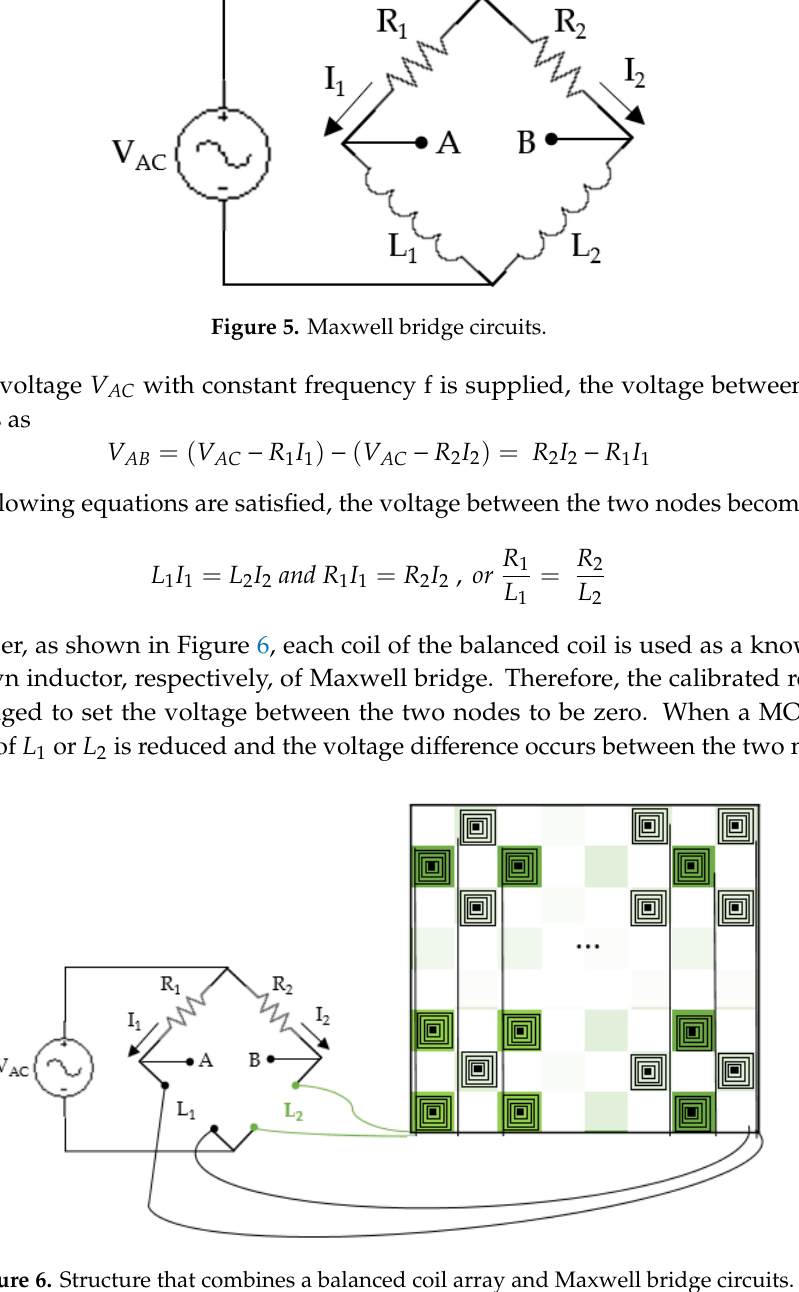
Figure 6. Structure that combines a balanced coil array and Maxwell bridge circuits.